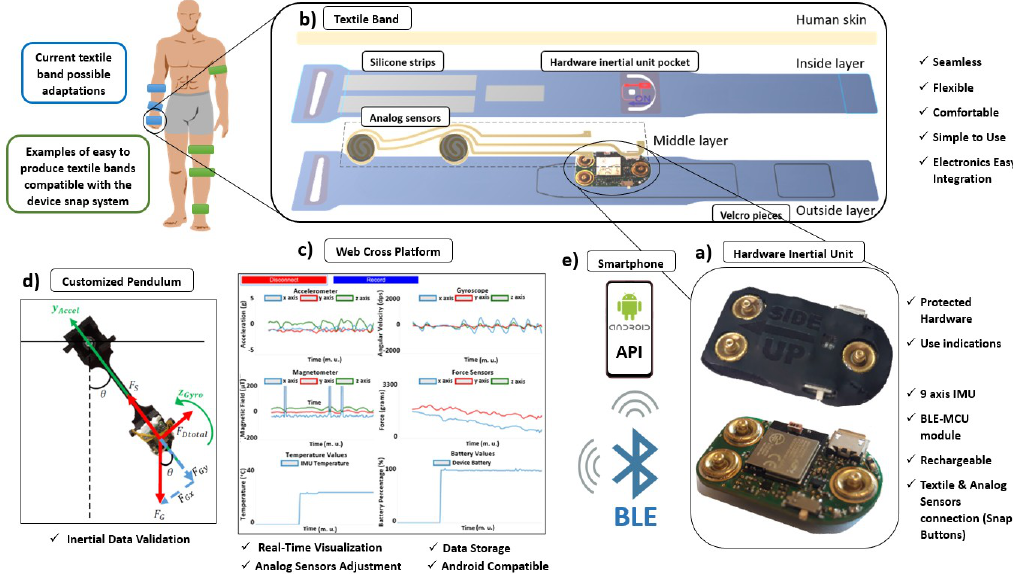
Figure 3. SnapKi wearable device surrounding system: ( a ) SnapKi hardware inertial unit exposed and coated. ( b ) Customized textile band for hardware inertial unit and analog sensors integration. ( c ) Web cross platform for data visualization and saving. ( d ) Customized pendulum for inertial data validation & device calibration. ( e ) Smartphone for data processing and visualization during patients use.